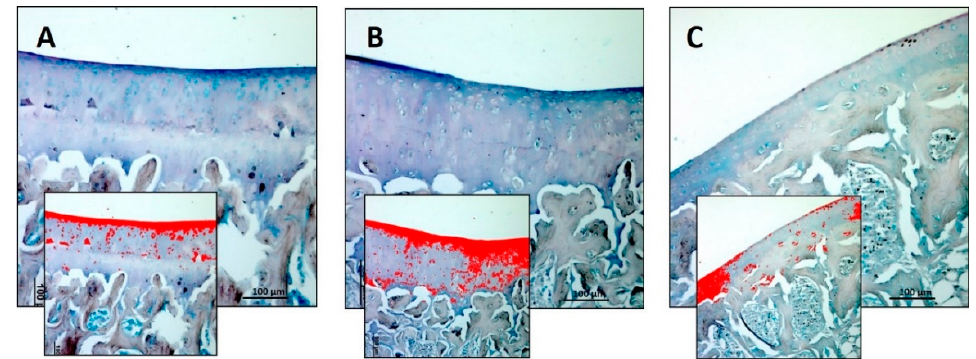
Figure 2. Histochemical evaluation of the mucosubstance content glycosaminoglycan (GAGs) in the articular cartilage by Alcian Blue staining through computerised densitometric measurements and image analysis. ( A ) R group; ( B ) R-DS group; ( C ) R-DR group. In inserts are the image analyses by the software in which the red colour represents Alcian Blue staining, showing a decreased staining in the R-DR group and increased staining in the R-DS group. For details, see the text. ( A – C ) Objective lens, 10; scale bars: 100 μ m. These are the most representative images of articular cartilage from rats of each group (R, R-DS and R-DR). Table 3. ALCIAN BLUE Staining—Articular